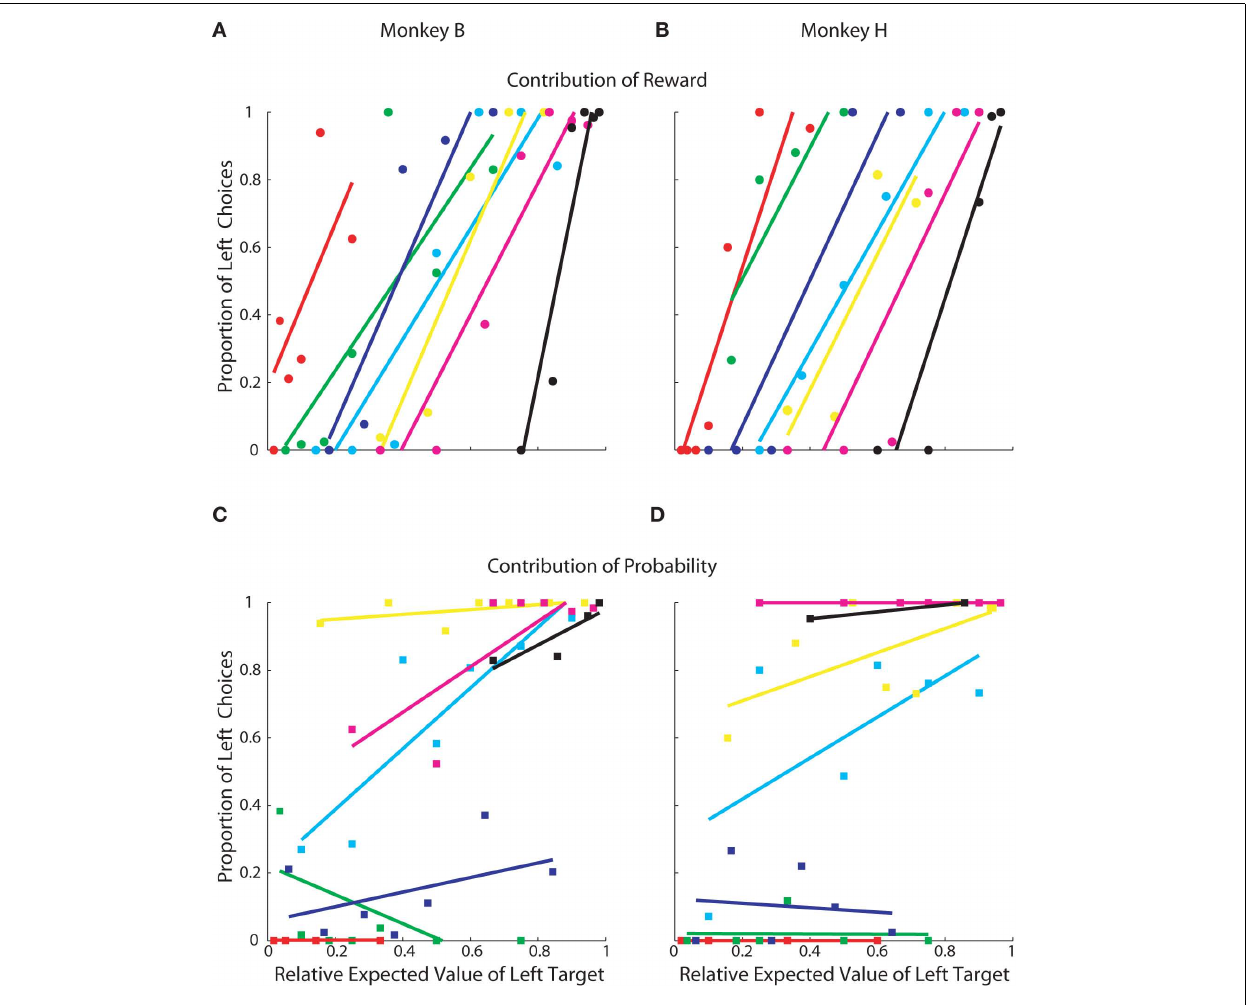
probability, followed by green, blue, cyan, yellow, magenta, and black was the highest. See Table 1 for exact values. (C,D) Contribution of reward probability. Each color indicates a group of prospects with the same reward magnitude and each point within the colored groups represents a different reward